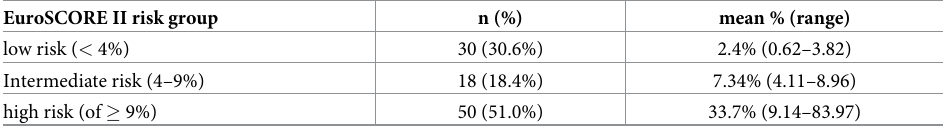
Table 2. EuroSCORE II risk